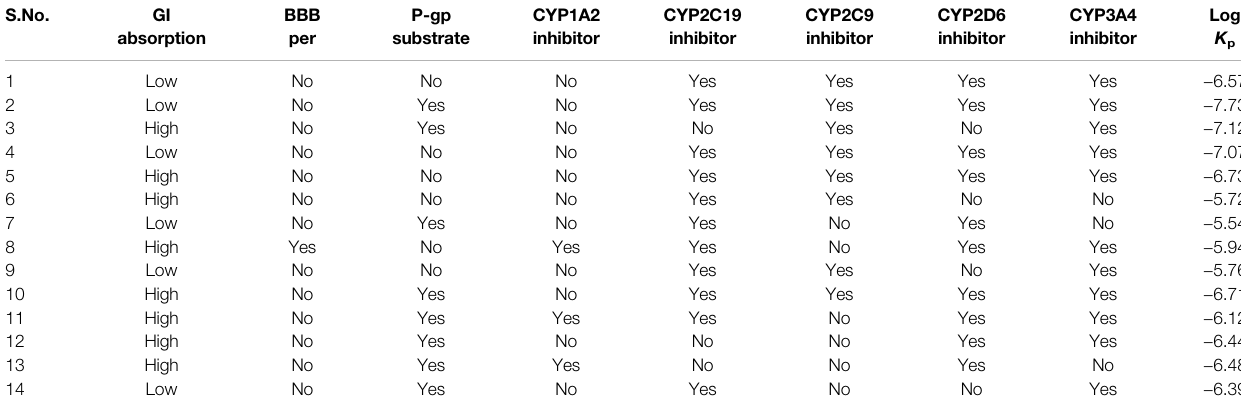
TABLE 6 | Pharmacokinetic properties of 14 multikinase inhibitors from BOILED-Egg in Swiss ADME software tools. S.No. GI BBB P-gp absorption per